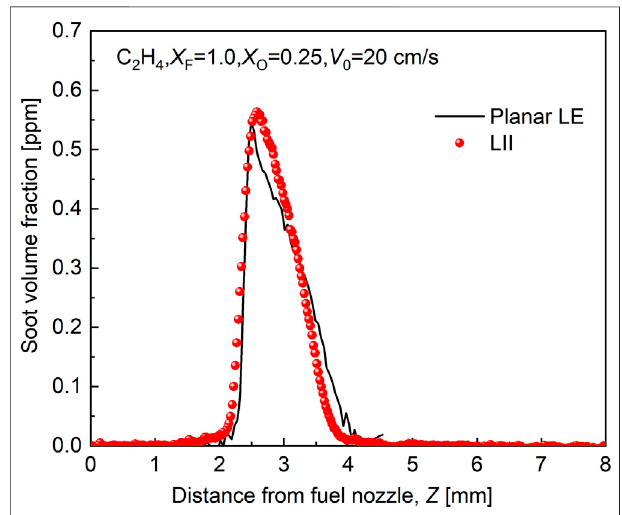
FIGURE 8 | Comparison of LII and planar LE measurement with the diffuse optical